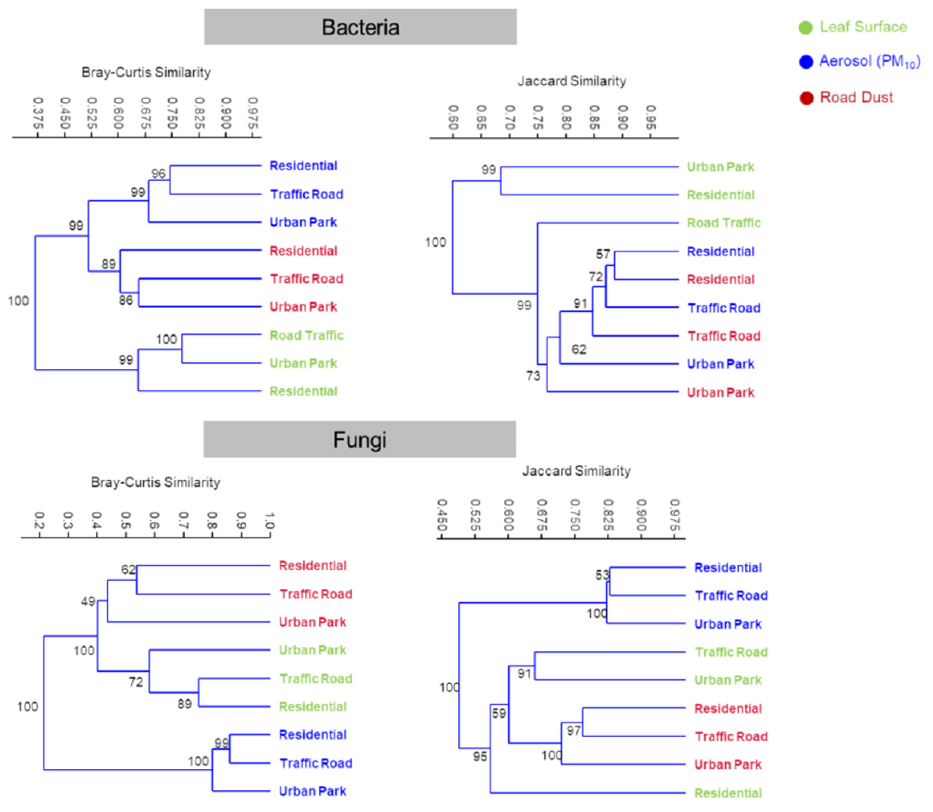
Figure 4. Compositional comparison of all sample types in a UPGMA (unweighted pair group method with arithmetic mean) non-hierarchical clustering ordination. Clusters are constructed from a Bray-Curtis similarity matrix of species-level-OTUs abundances and Jaccard similarity matrix of species-level-OTUs presences for bacteria and fungi, computed between aerosol (PM 10 ), road dust and leaf surface samples collected in three urban sites of Rome (Urban Park, Residential and Road